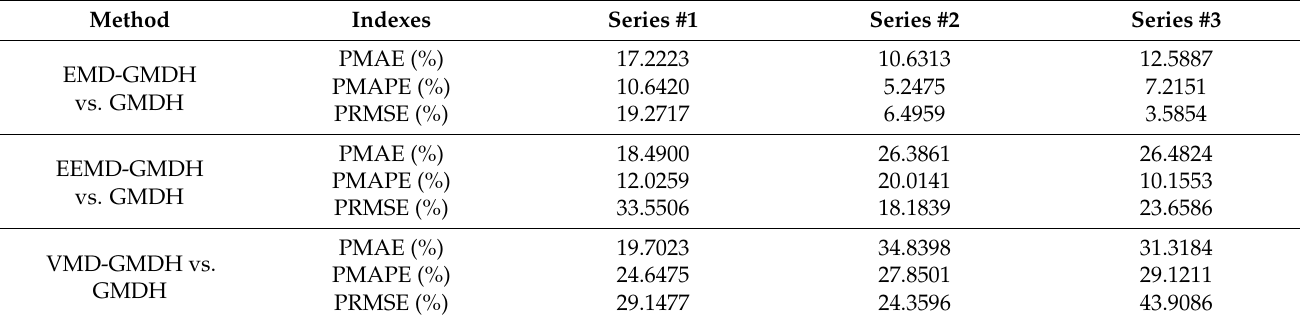
Table 6. The promoting percentages of the EMD decomposition models and the VMD decomposition